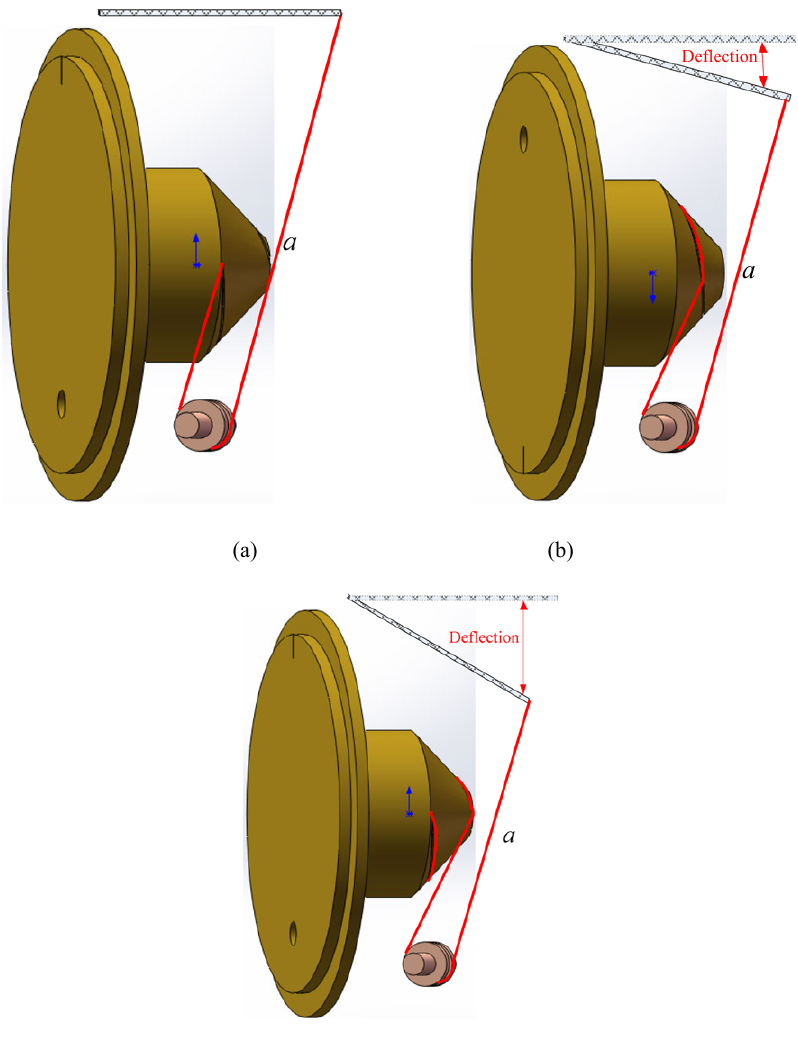
Fig. 2 Joint working processes of the proposed FBG rotation angle sensor: (a) rotation angle 0 ˚ , (b) rotation angle 180 ˚ , and (c) totation angle 360 ˚